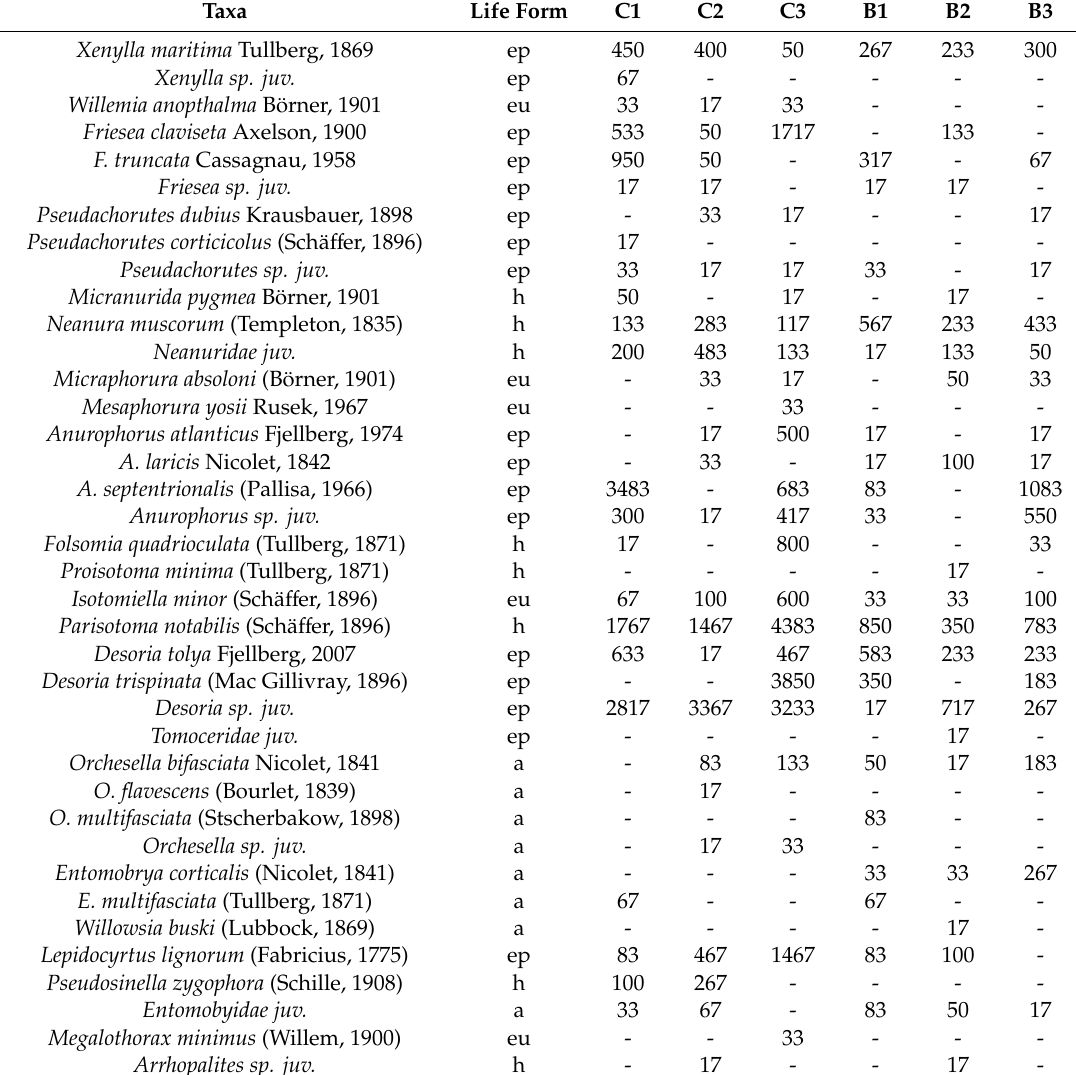
Table 1. Species list, life forms, and mean abundance (ind. m − 2 ) of Collembola in plots bioturbated by wild boars (B1, B2, B3) and control plots (C1, C2, C3). Life forms: a, atmobiotic; ep, epedaphic; eu, euedaphic; h, hemiedaphic. The life form classification of taxa is according to Babenko et al. [43], Rusek [44], and Potapov et al.